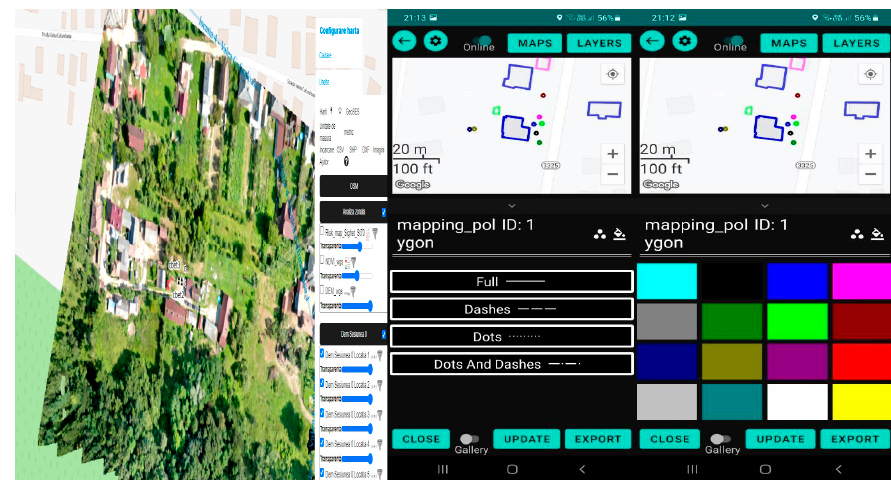
Figure 4. WebGIS portal and mobile application. Source: GeoSES project [38].